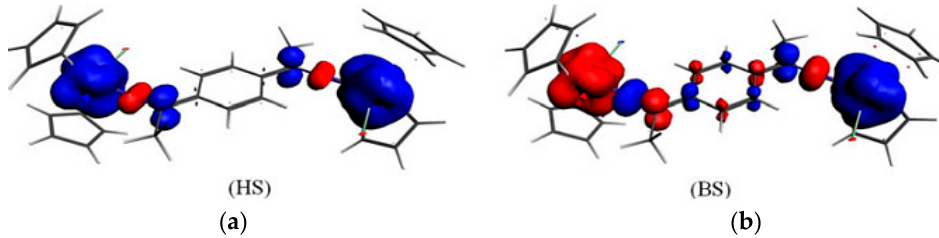
Figure 15. ZORA/B3LYP spin-density (difference of alpha and beta electron densities) distribution plots for the HS ( a ) triplet and BS states ( b ) of U 2 bis(ketimide) (blue color: positive spin density and red color: negative spin density). (Reprinted with permission from [147], Springer-Verlag, 2012).